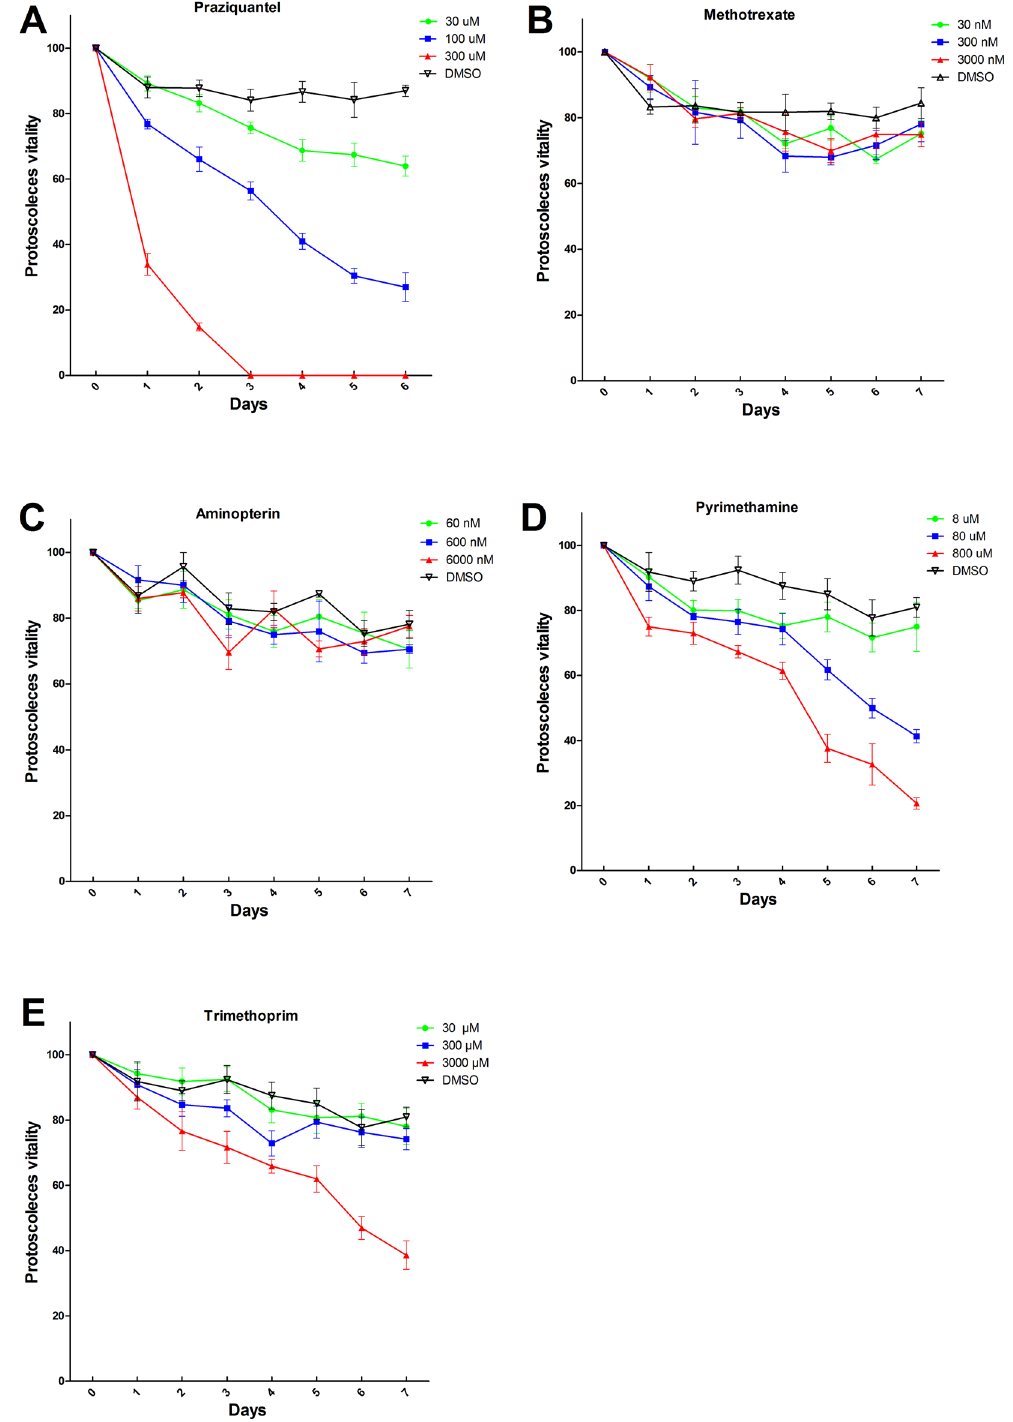
Figure 6. The protoscolicidal activity of antifolates in vitro . Vitality of protoscoleces (PSCs) following in vitro treatment with different concentrations of antifolates. Statistically significant differences were compared by analysis of variance (ANOVA). A value of P < 0.05 was considered statistically significant. ( A ) Praziquantel, ANOVA: F (3, 24) = 10.87, P < 0.0001. ( B ) Methotrexate, ANOVA: F (3, 28) = 0.3907, P = 0.7606. ( C ) Aminopterin, ANOVA: F (3, 28) = 0.4456, P = 0.7223. ( D ) Pyrimethamine, ANOVA: F (3, 28) = 4.431, P = 0.0114. ( E ) Trimethoprim, ANOVA: F (3, 28) = 4.444, P = 0.113. Data shown are mean values from three